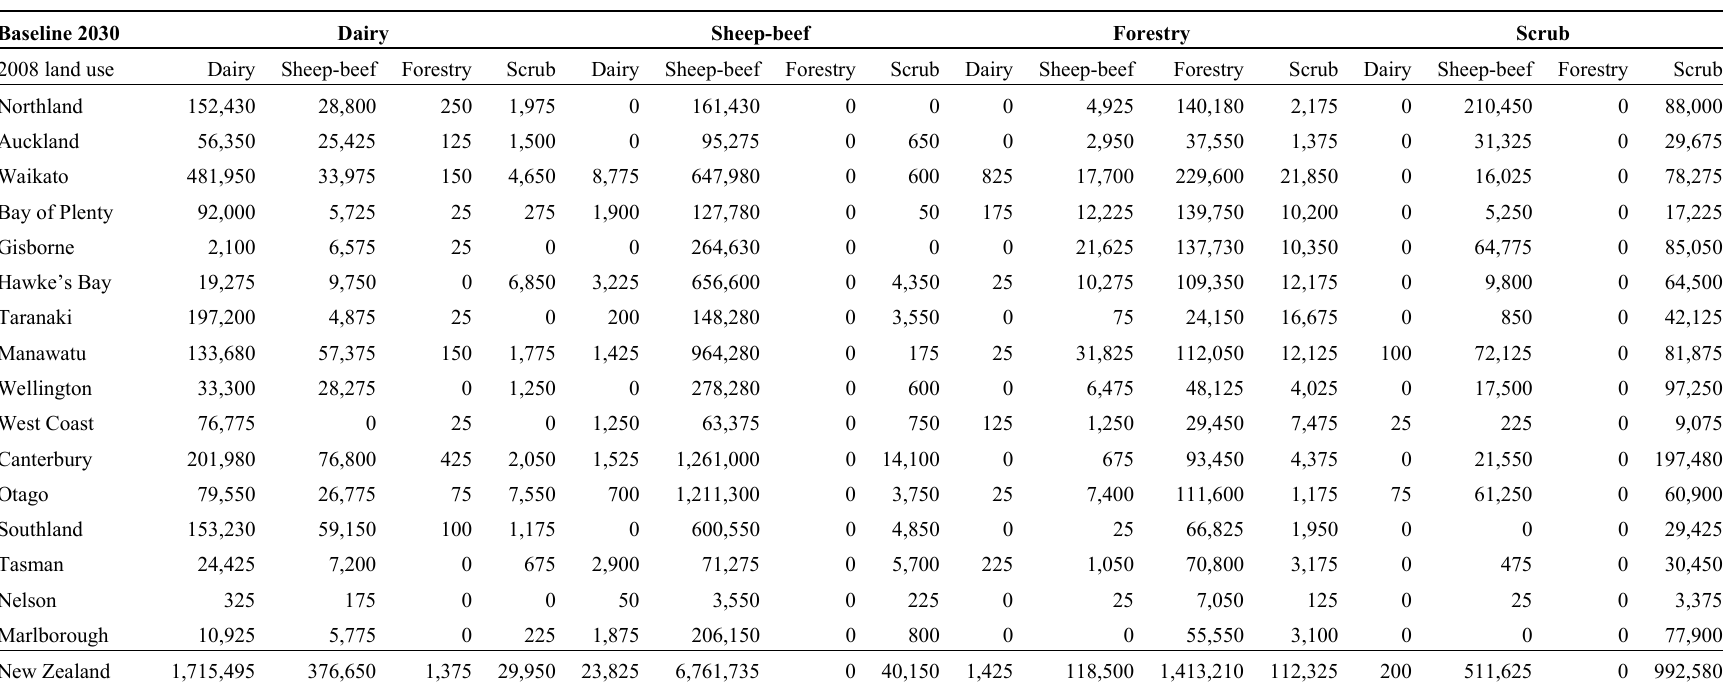
Table 1. Land-use change (in hectares) between 2008 and 2030 under the projected baseline by regional council. Baseline